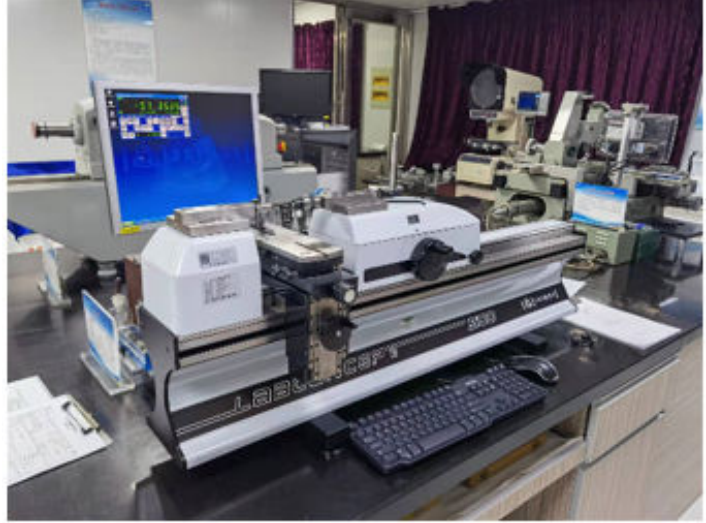
Figure 17. Picture of the TRIMOS